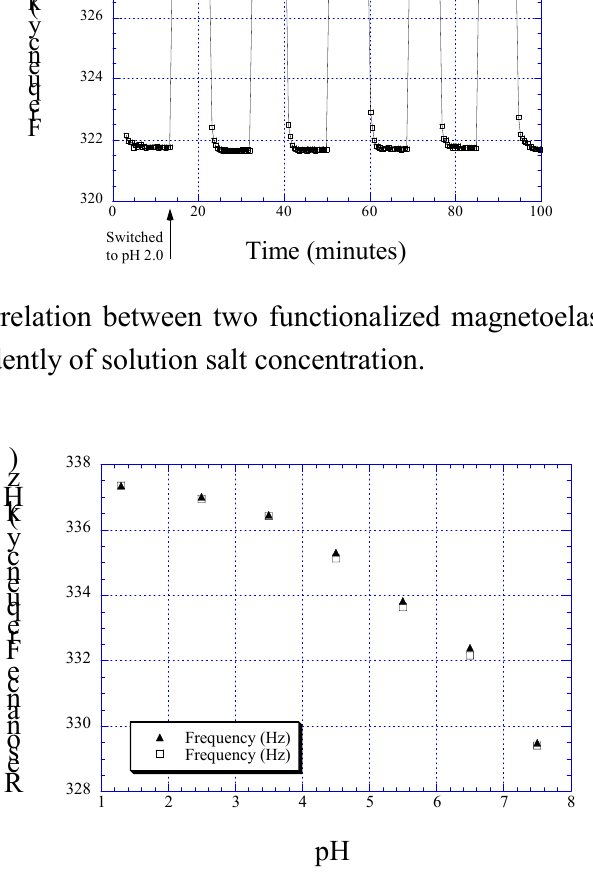
Figure 15b. Frequency response of pH sensor measured at decreasing pH values, and then increasing pH values; measurements were taken every 20 minutes after change in solution